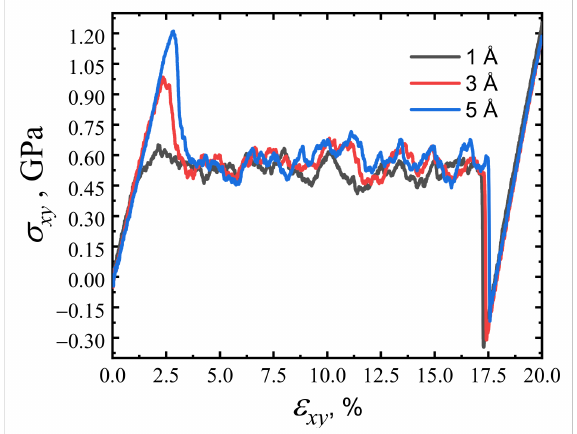
Figure 3. The shear stress–strain curves for the bicrystals with Cr segregation at GB. The corre- sponding thickness of the segregated layer (1, 3 or 5 Å) is indicated in the legend. The considered temperature is 300 K.